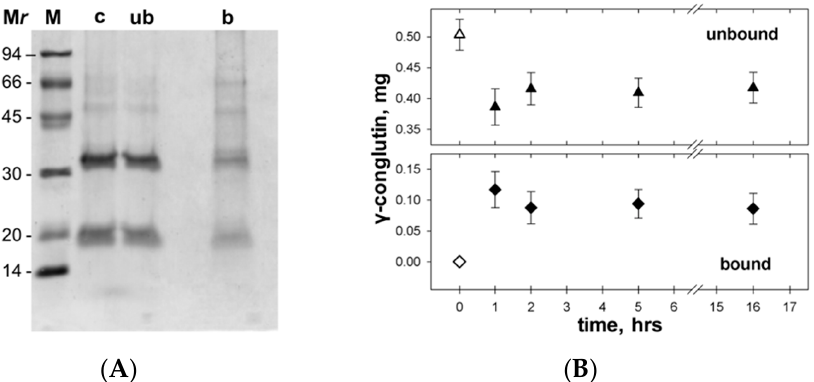
Figure 4. Adsorption of γ C to polystyrene nanoparticles (NPs). Experimental details are given in the text. ( A ) SDS-PAGE of γ C used for the experiment (c), unbound (ub), and bound (b) to NPs. The M r s of the markers (M) are given in kDa; ( B ) quantification of γ C remained unbound (closed triangles) or bound (closed diamonds) to the NPs during incubation. Open symbols indicate the initial amounts of protein.